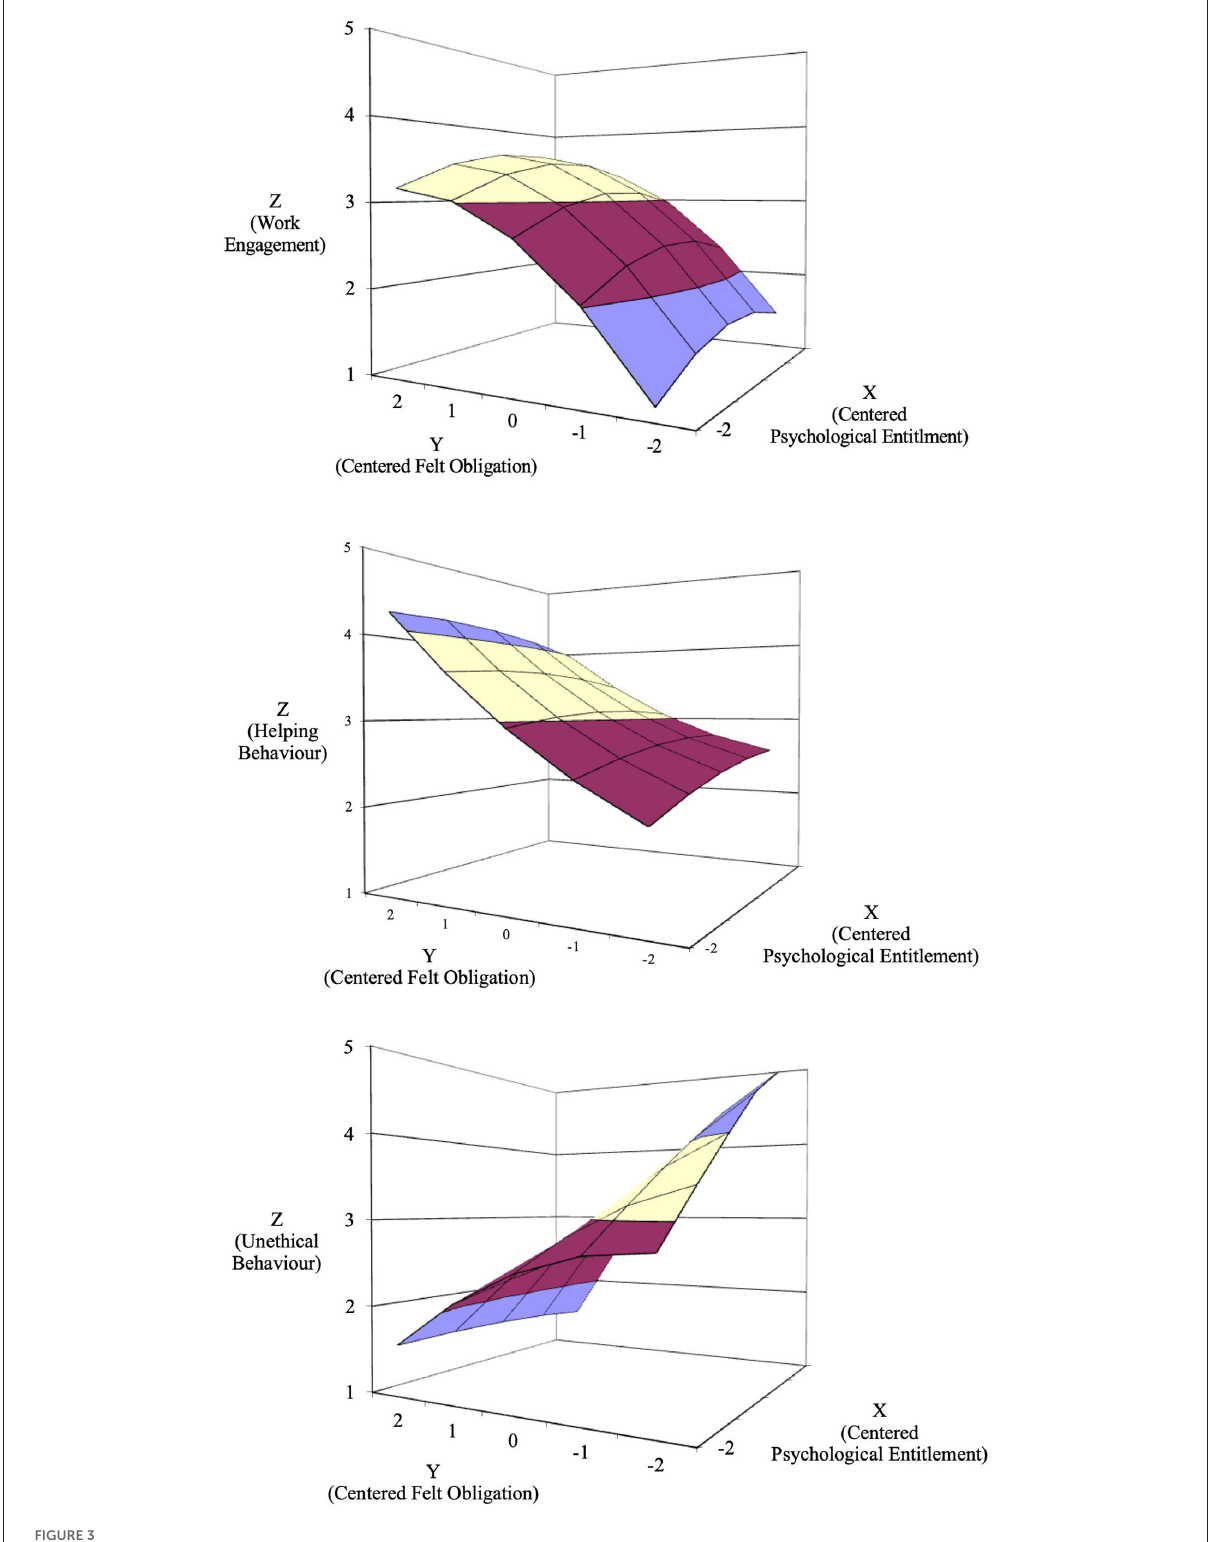
FIGURE3 Response surface analysis